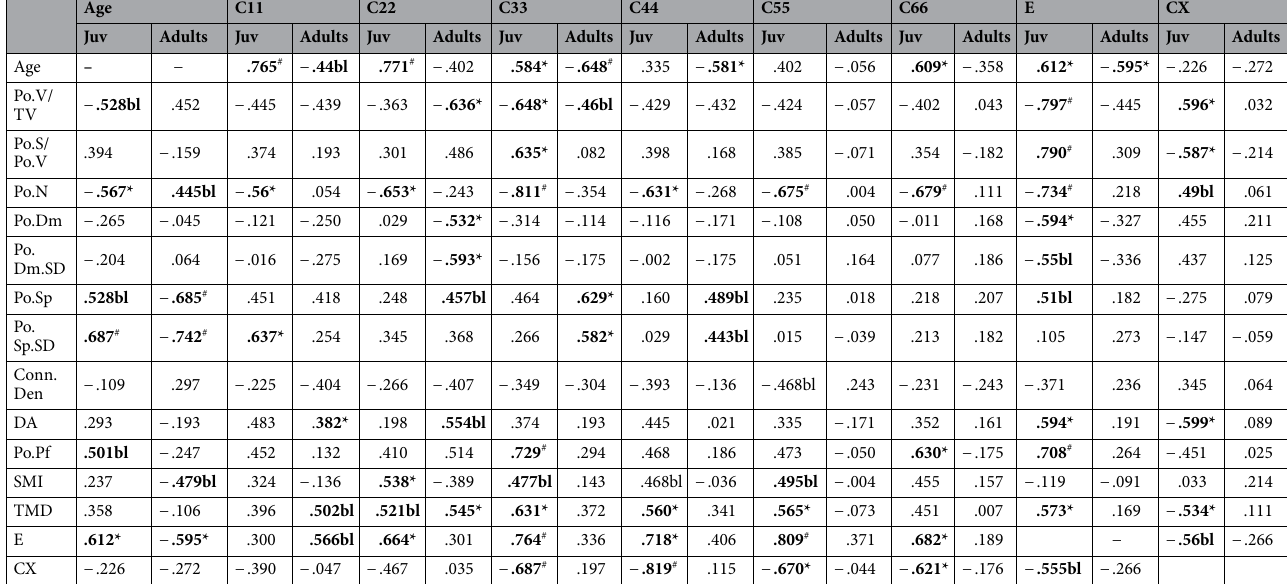
Table 2. Spearman correlation coefficients (r ′ ) obtained between chronological age, elastic coefficients, elastic modus and ration of immature/mature cross-links, and the different parameters of the microstructure analysis obtained by μCT (* p < 0.05, # p < 0.01, Juv. represents the juvenile group). Bold correspond to significant correlation. Juv., Juveniles. * p < 0.05, bl: borderline: 0.051 < p < 0.099. # p <